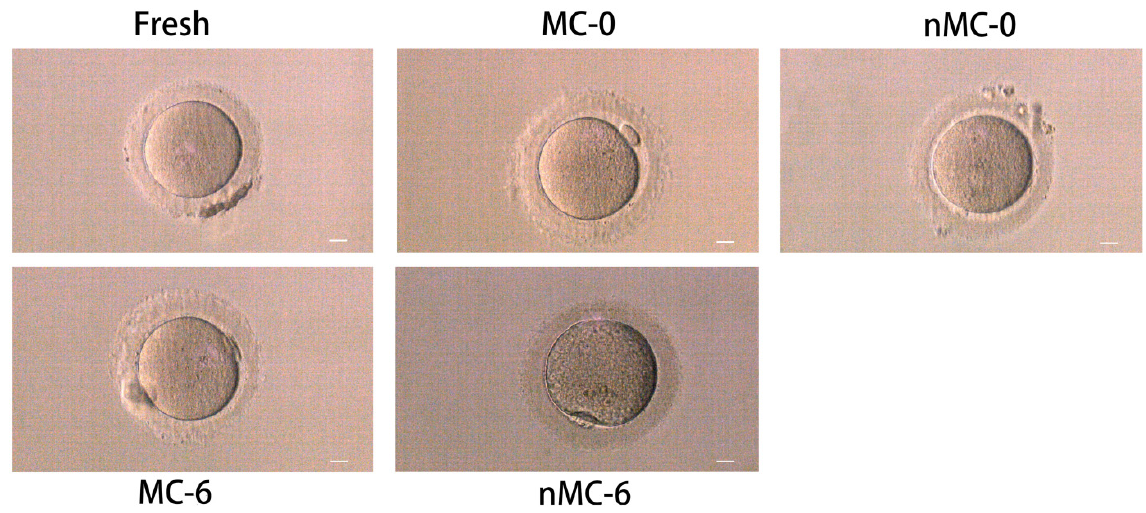
Figure 1. Effect of 10 -9 M MT treatment on the effect of cryopreserved human oocytes from the nMC-0 group, MC-0 group, nMC-6 group and MC-6 group. The fresh group served as control. The morphological changes of oocytes were observed under an optical microscope: (1) vacuoles and granulation clusters in the cytoplasm of human oocytes in the nMC-0 group and nMC-6 group; (2) the coarsest cytoplasm and the most severe vacuolization in the nMC-6 group; (3) a large perivitelline space in the nMC-0 group; (4) normal morphology and uniform cytoplasm in the MC-0 group, MC-6 group and F group. Bar=10 µm.